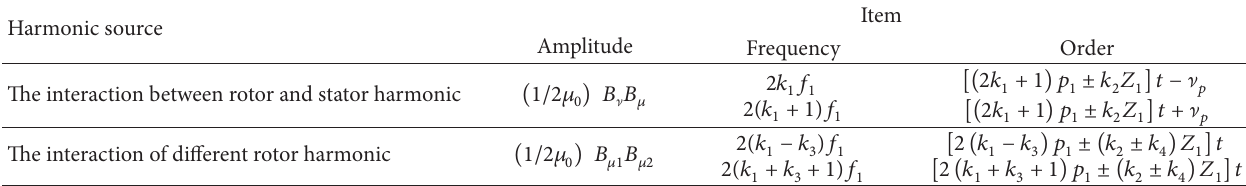
Table 1: Main normal electromagnetic force.